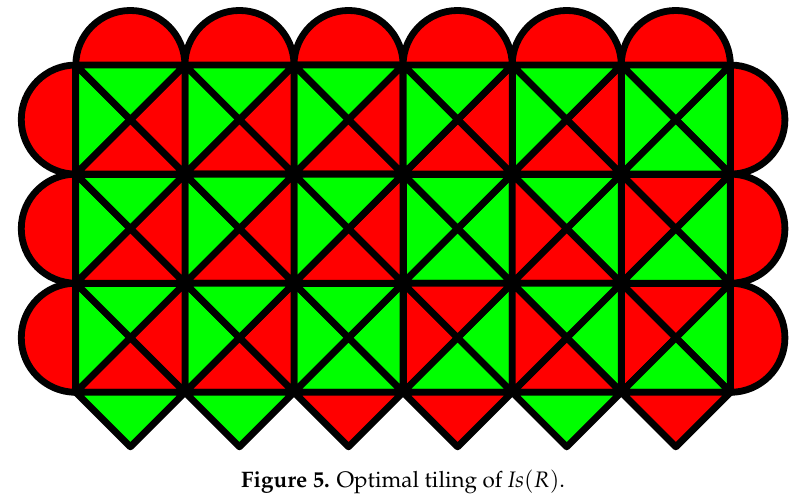
Figure 5. Optimal tiling of Is ( R )